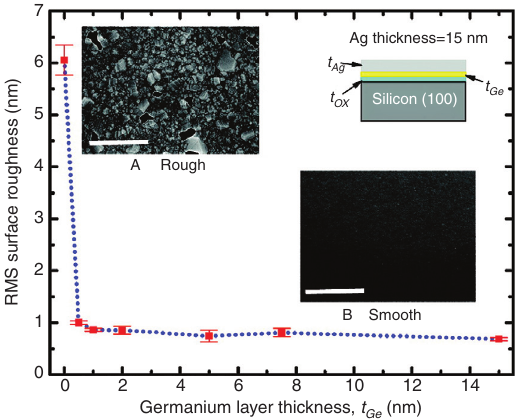
Figure 6: Variation of the RMS with the Ge seed layer thickness. Reproduced with permission from